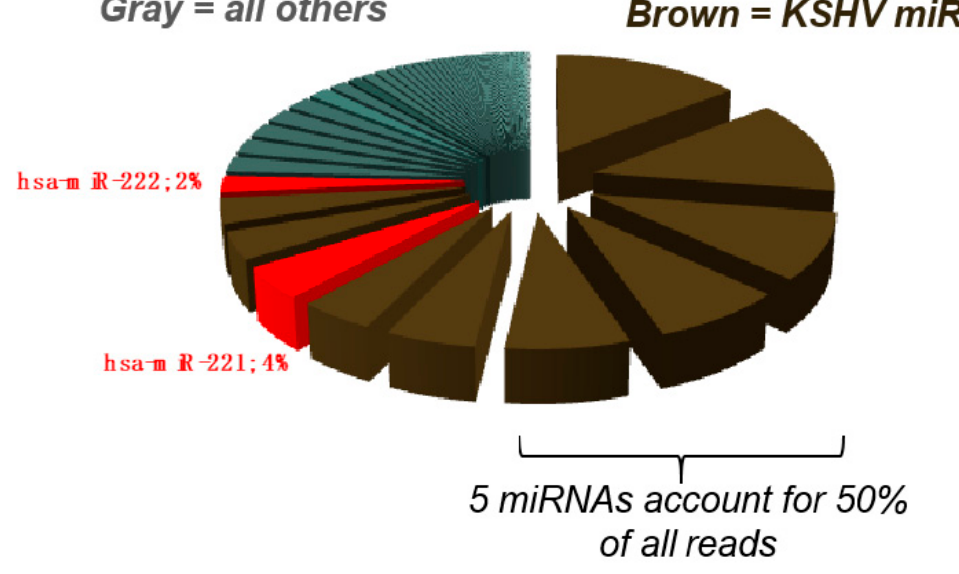
Figure 2. 70% of all miRNAs in infected human vein endothelial cells (HUVECs) come from